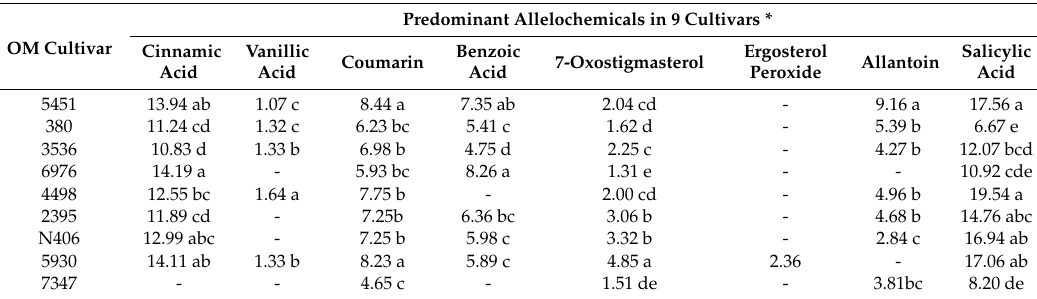
Table 5. Relative abundance of predominant allelochemicals in 9 tested rice